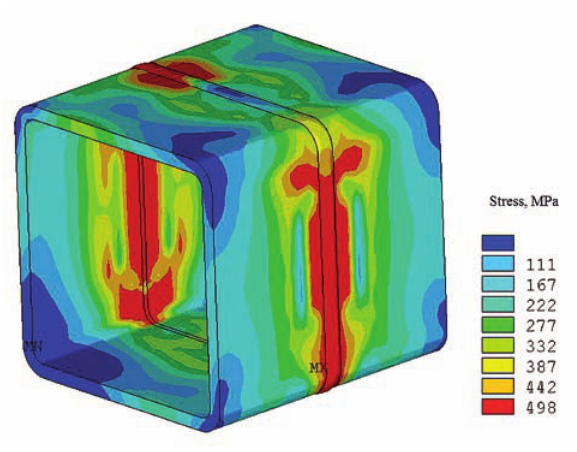
Fig. 18. Von Misses stress fields as joint is cooling down to room temperature, MPa